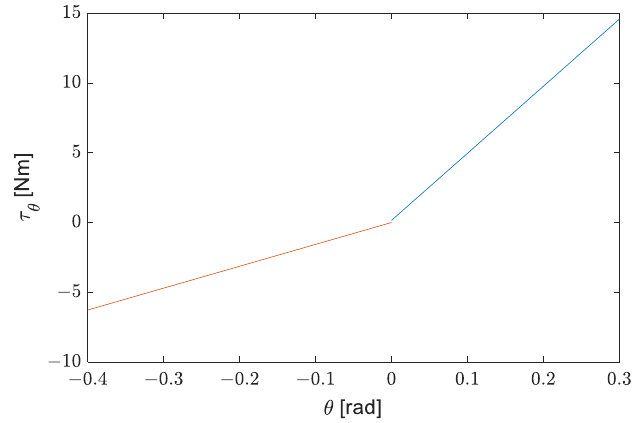
Figure 2. Passive ankle stiffness for a dorsiflexion-plantarflexion movement in stroke survivors.